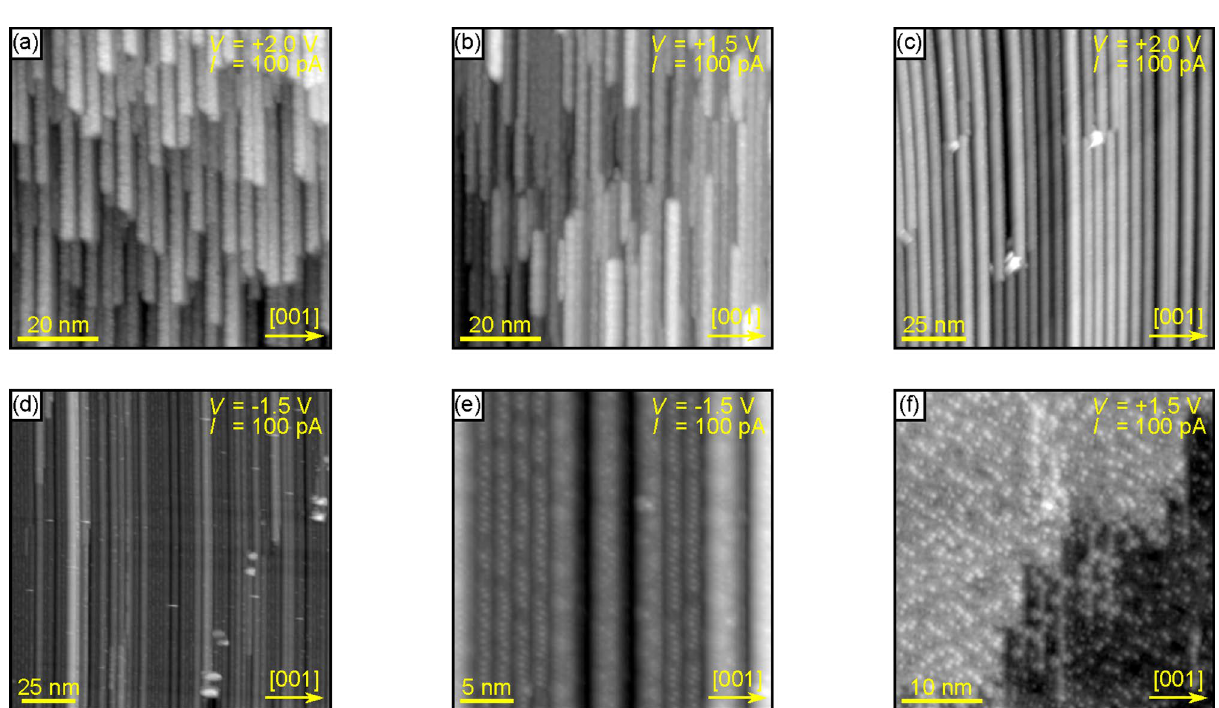
Figure 8. Chronologically measured STM images of the nanowire preparation shown in Fig. 3d after ( a ) 10 days in UHV, ( b ) an additional anneal at about 500 ◦ C , ( c ) a subsequent anneal at about 750 ◦ C (13 days in UHV), and ( d – f ) reannealing at about 850 ◦ C . The red line in ( e ) highlights triangular